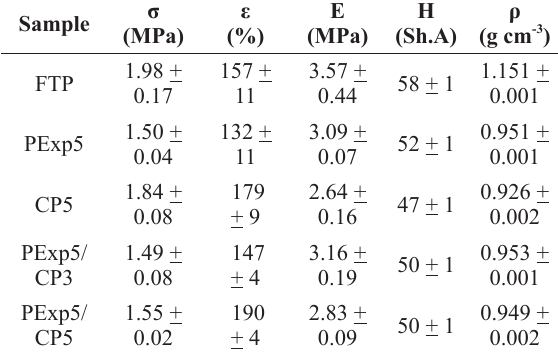
Results of mechanical properties and